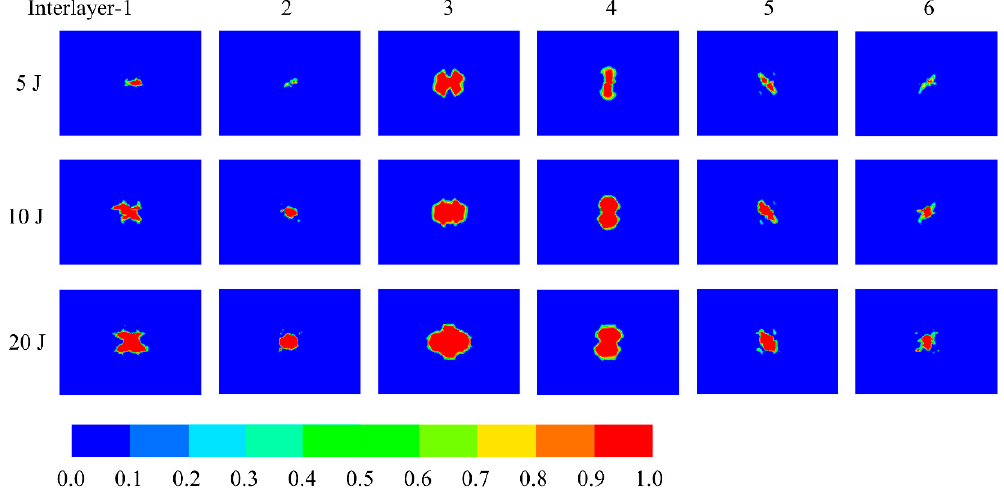
Figure 11. Distribution of interlaminar damage variables of upper sheet under impact.